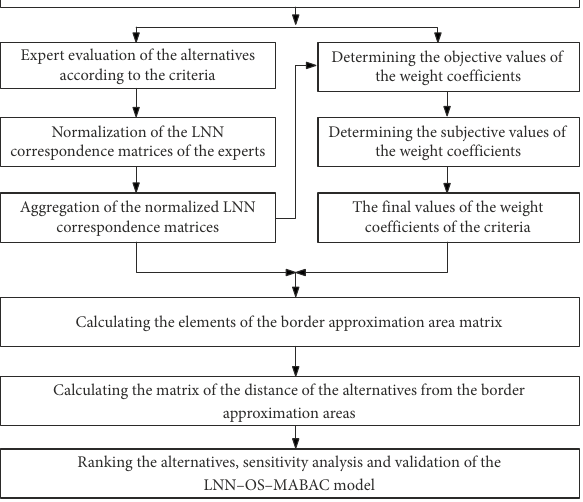
Figure 1. Framework of the proposed